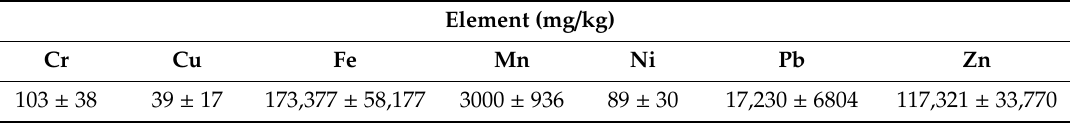
Table 1. Average soil metal content (mg / kg dry weight) at La Gardie mine site.